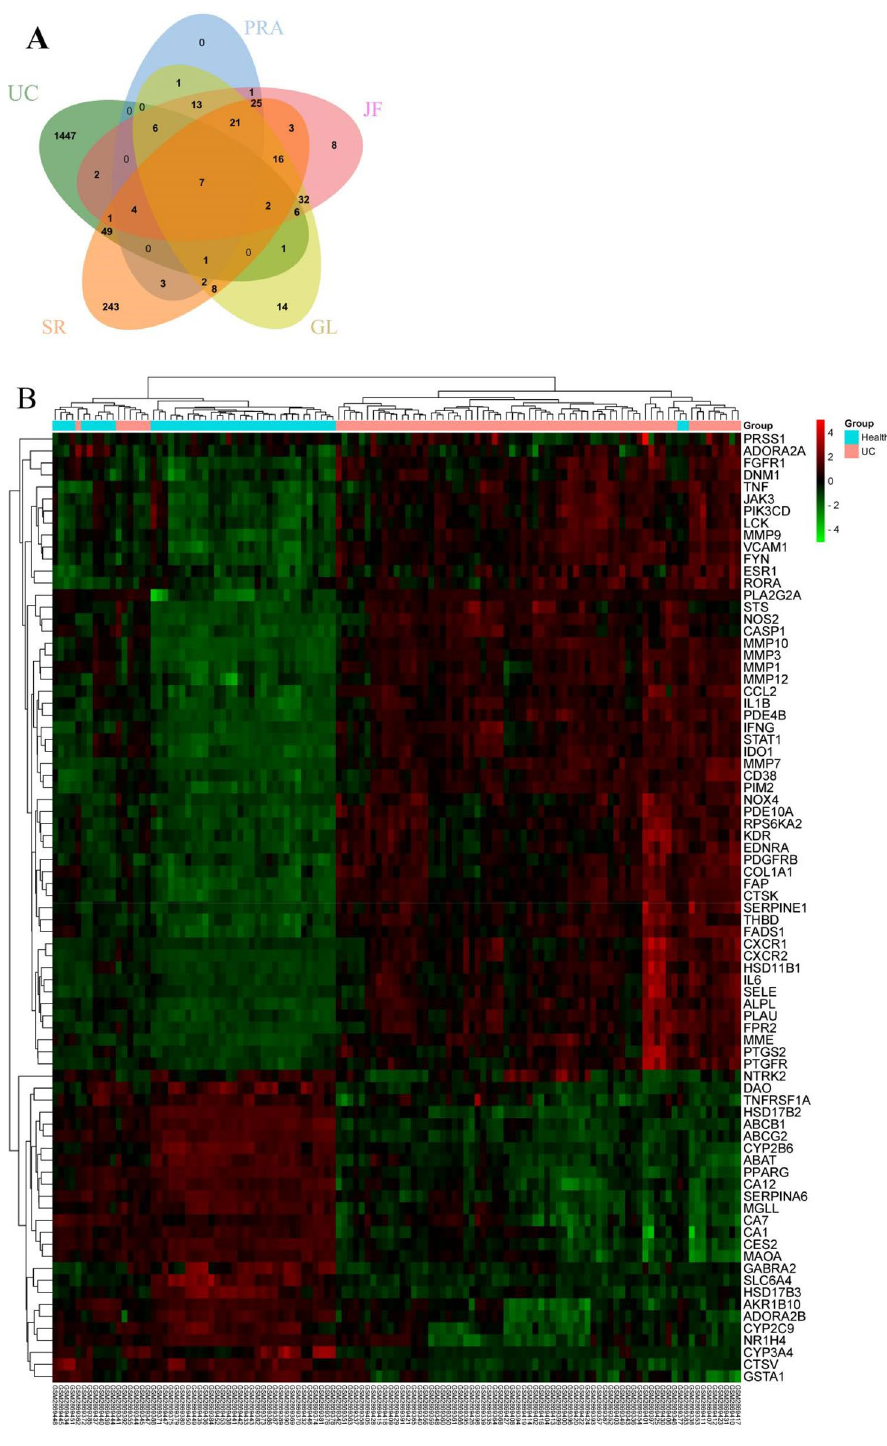
Figure 4. 79 co-targets. ( A ) Venn analysis. The green is ulcerative colitis (1542 targets), blue is Paeoniae Radix Alba (84 targets), pink is Jujubae Fructus (147 targets), yellow is Glycyrrhiza glabra L. (130 targets), orange is Scutellariae Radix (385 targets). ( B ) Heatmap. Red dots are upregulated expression. Green dots are downregulated